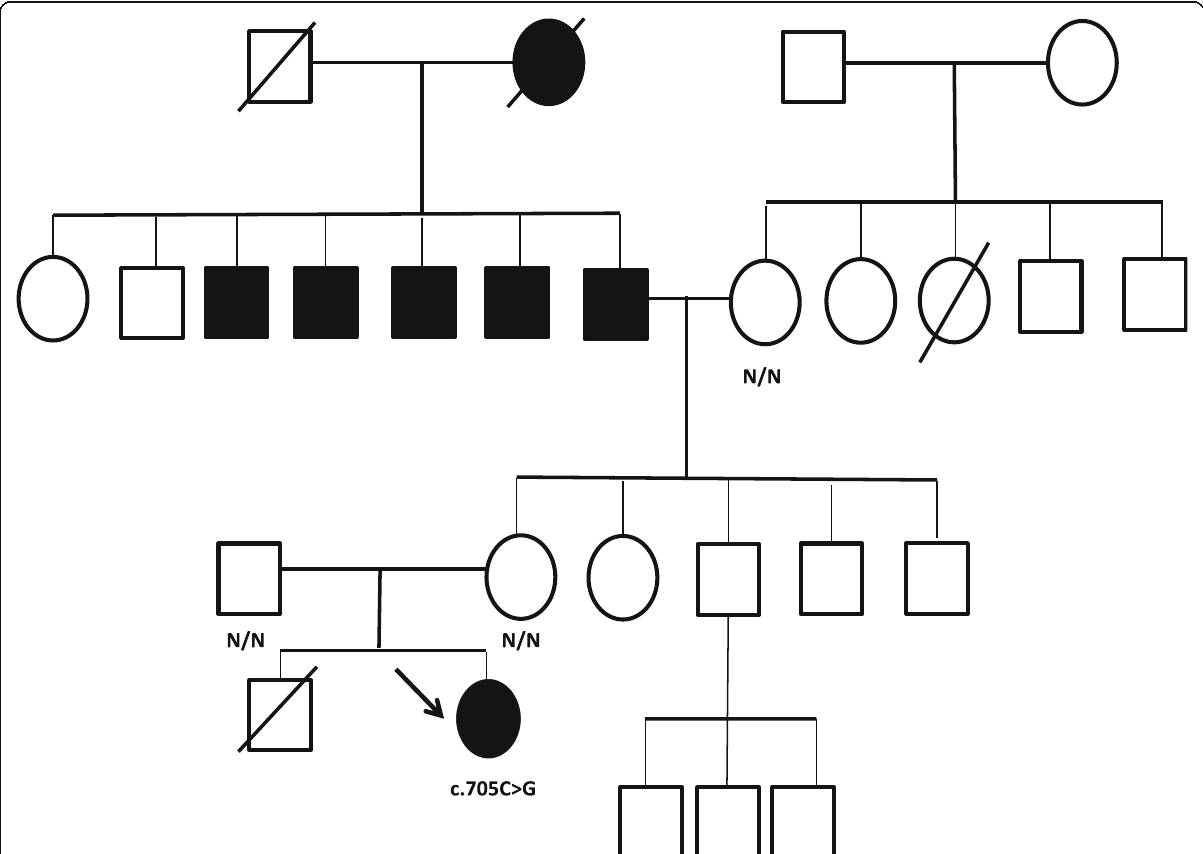
Fig. 1 Family pedigree. An arrow points to the index case . Squares represent male family members, and circles represent female family members. Filled black symbols represent people with diabetes. Genotype is shown underneath each symbol. N/N denotes no mutation